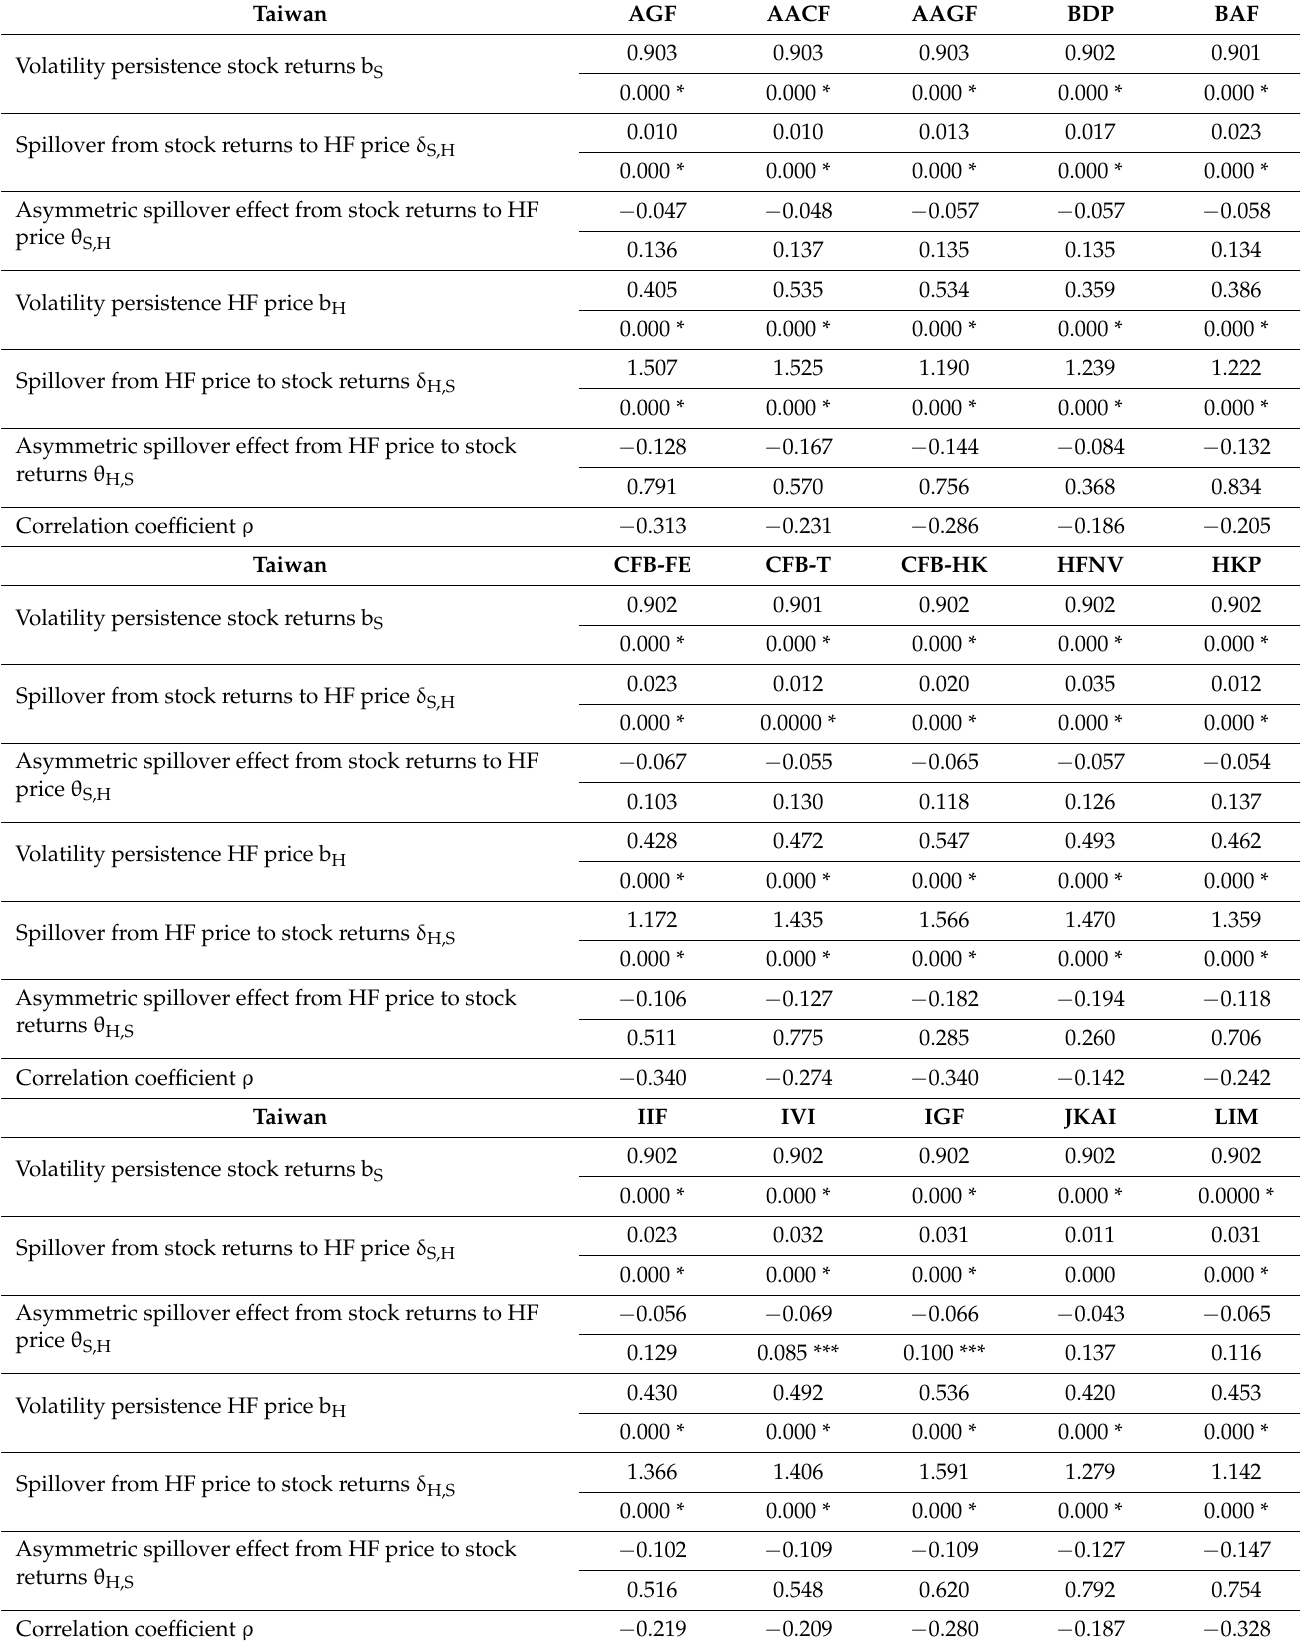
Table 13. Volatility spillover between the Taiwanese Stock Market (TWSE) and Hedge Fund